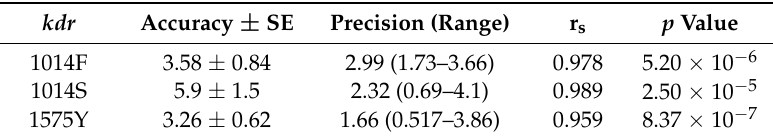
Table 2. Application of the developed regression models in an independent set of artificial populations (validation set). Calculation of accuracy and precision of the method and correlation between true and estimated allelic